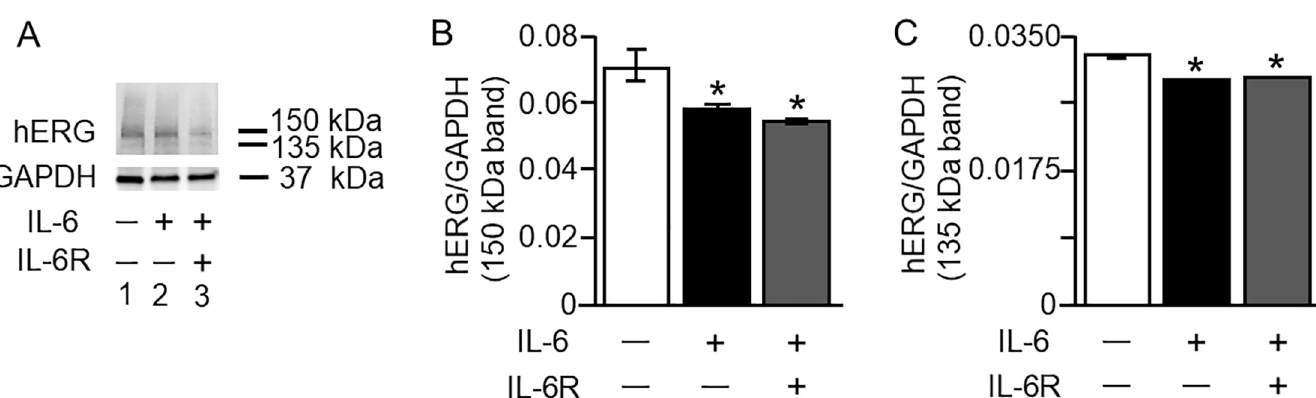
Fig 3. Effect of IL-6 on I protein expression in HEK-hERG cells. Western blot analysis of the I channel hERG expression in HEK-hERG cells from control cells Kr Kr and in cells pre-treated for 40 min with IL-6 (20 ng/ml) alone or IL-6 (20 ng/ml)+IL-6R (25 ng/ml). A , compared to control hERG protein expression ( Lane 1 ), exposure to IL-6 (20 ng/ml) reduced the expression of the 150 kDa and 135 kDa ( Lane 2 ) hERG proteins. A further decrease in the bands was observed ( Lane 3 ) with pretreatment with IL-6 (20 ng/ml) + IL-6R (25 ng/ml). Compared to untreated HEK-hERG cells ( Open bar , B and C ), normalized values of 150 kDa ( B ) and 135 kDa ( C ) hERG bands/GAPDH revealed significant down-regulation of the protein expression of hERG in the presence of IL-6 alone ( Black Bars , B and C ) or IL-6+IL-6R ( Grey Bars , B and C ). Equal amounts of protein were loaded in each lane. The 37 kDa bands represent GAPDH.